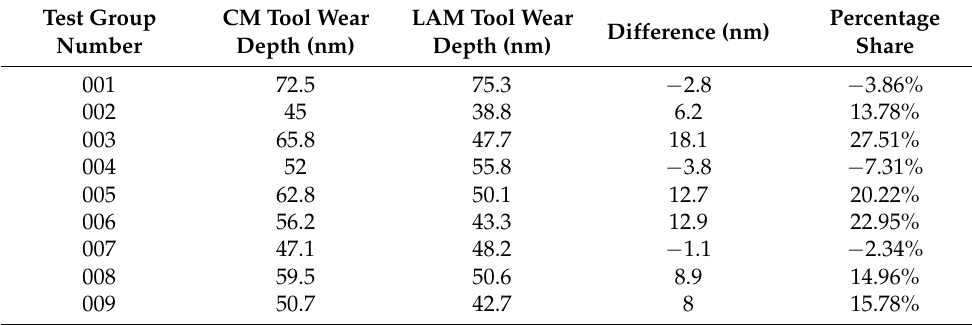
Figure 6. The wear depth of the rake face at v c = 50 m/min, f = 0.10 mm/r and ap = 0.5 mm: ( a ) conventional machining; ( b ) laser-assisted machining. Table 5. Comparison of tool wear depths.